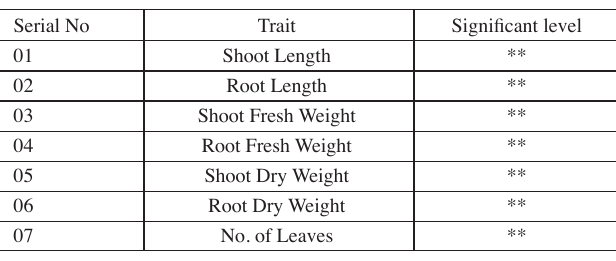
Tab. 3: Analysis of variance for individual trait (Morphological traits)